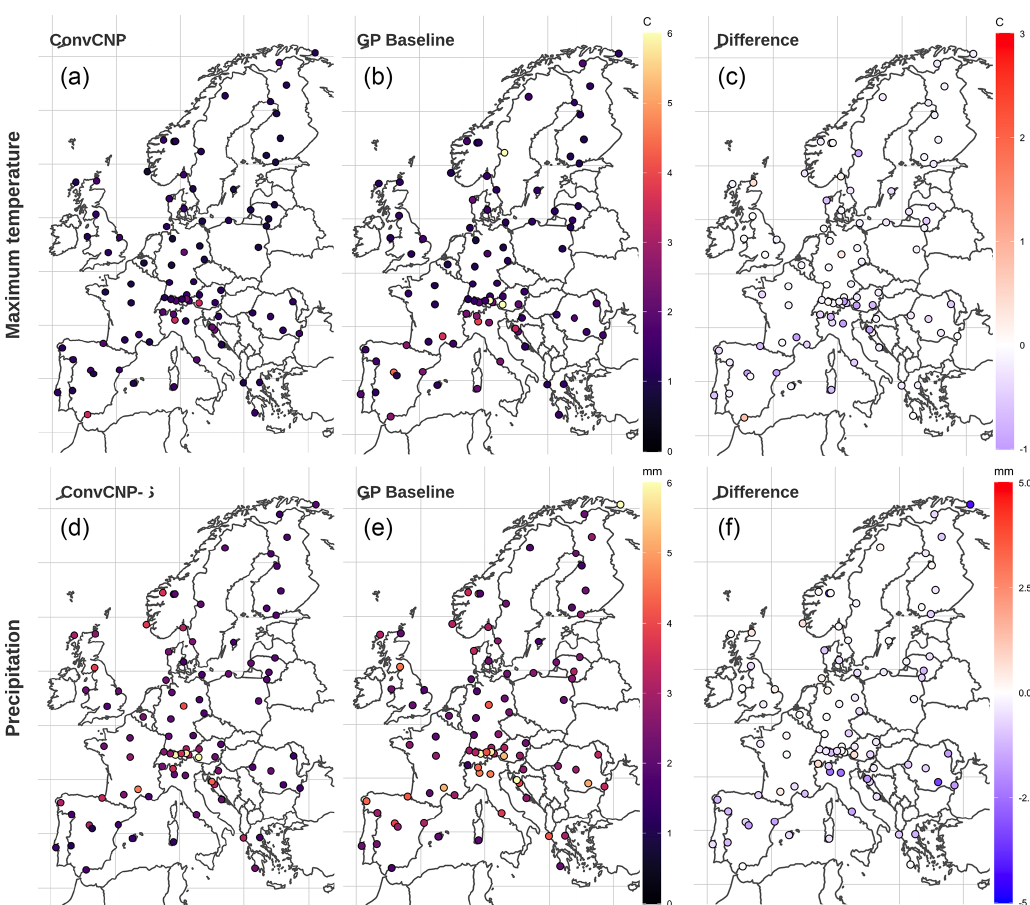
Figure 7. Spatial distribution of mean absolute error for convCNP (a, d) , GP-baseline (b, e) and convCNP–GP-baseline (c, f) . Maximum temperature (precipitation) is shown on the top (bottom) row. All panels show results for each of the 86 held-out VALUE